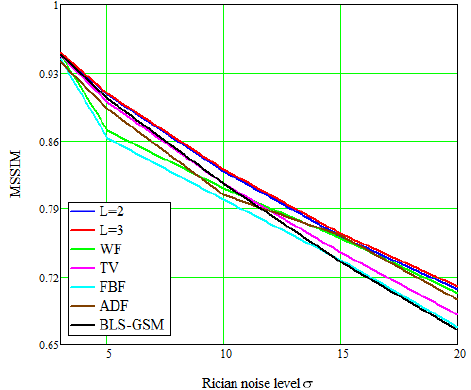
Figure 5. Comparison of measurements MSSIM of method with different Rician noise levels